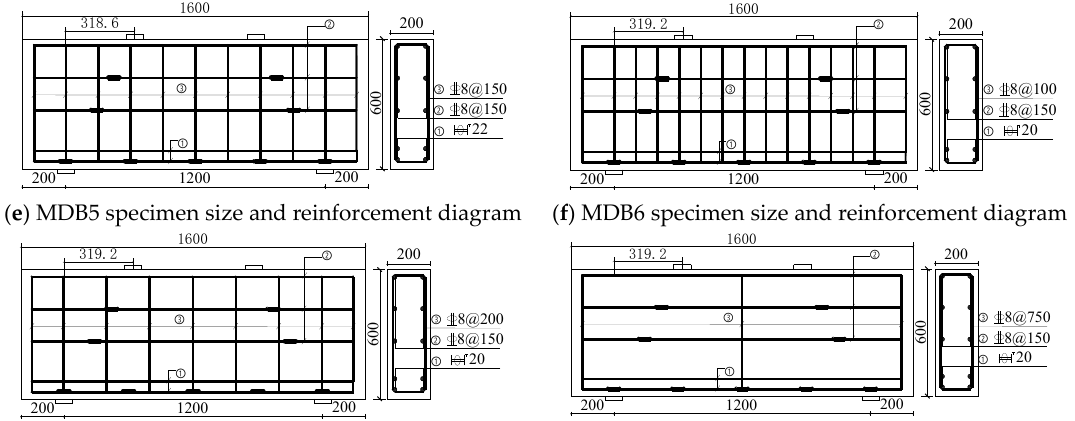
Figure 1. Geometric dimension of test specimen and layout of steel strain gauge.